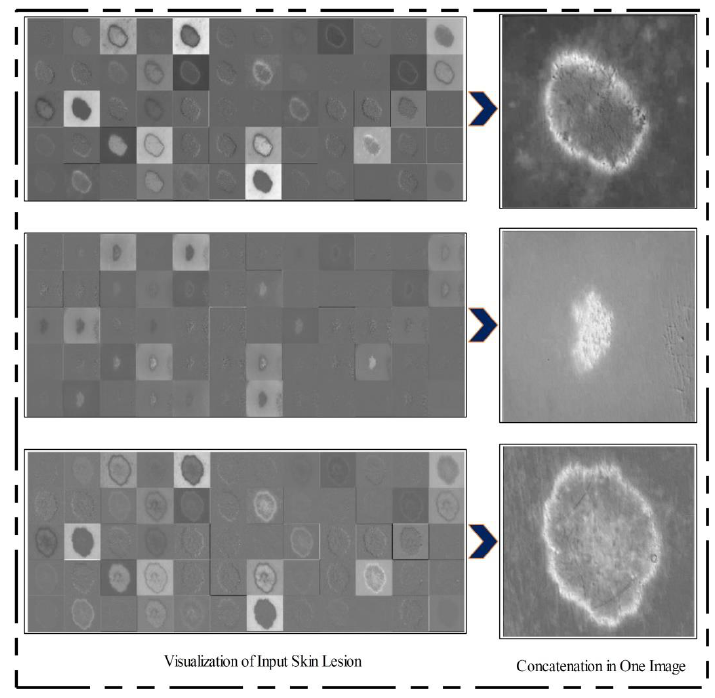
Figure 8. Feature visualization of the third convolutional layer.